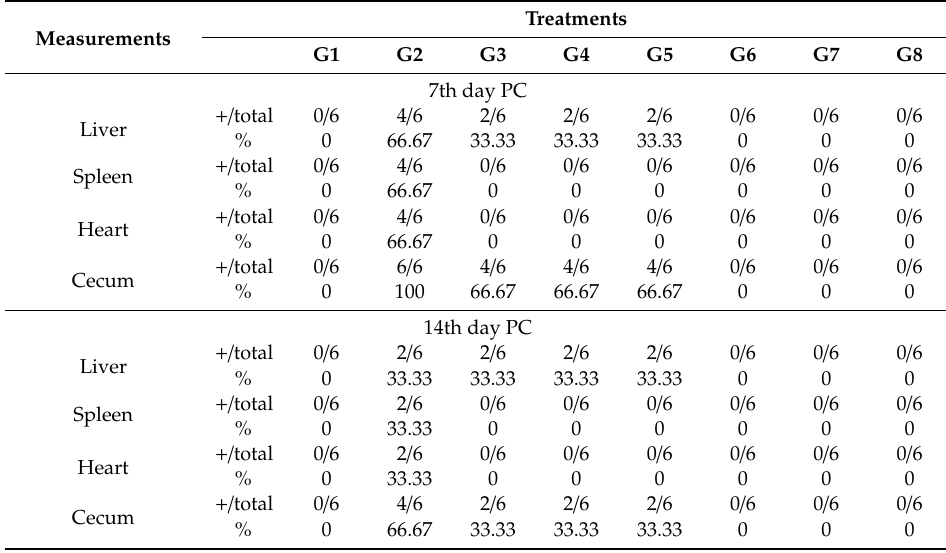
Figure 3. Re-isolation rate of SE from di ff erent organs (number of positive birds for each organ / six sacrificed broiler chickens / group). Table 1. Re-isolation rate of SE from di ff erent organs: (number of positive birds for each organ / six sacrificed broiler chickens /